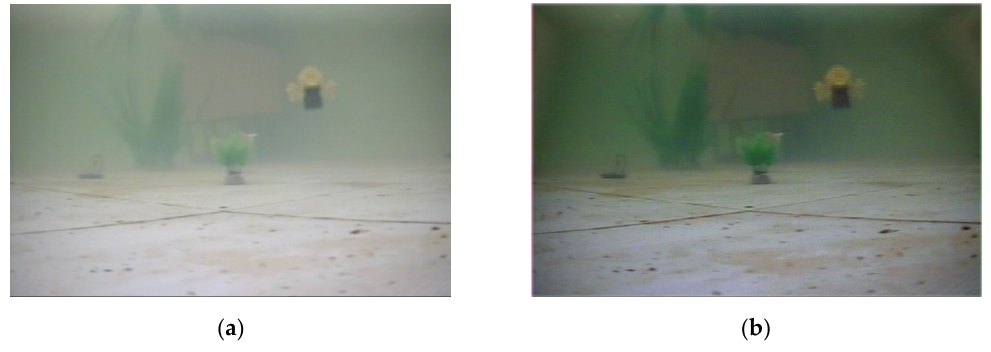
Figure 2. ( a ) The original optical image; ( b ) the image after enhancement.